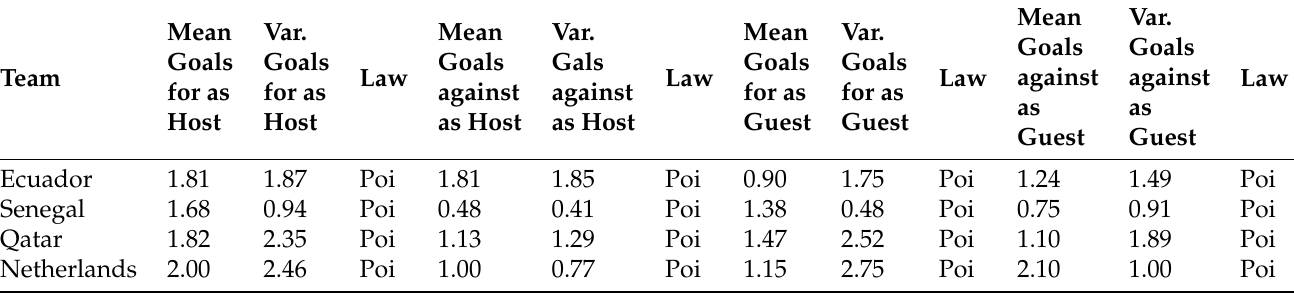
Table 19. Group A in Qatar